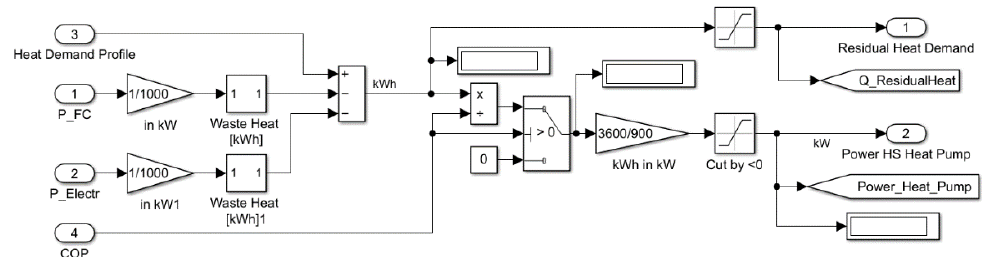
Figure 12. Calculation of residual heating demand and the required heat pump power and energy.